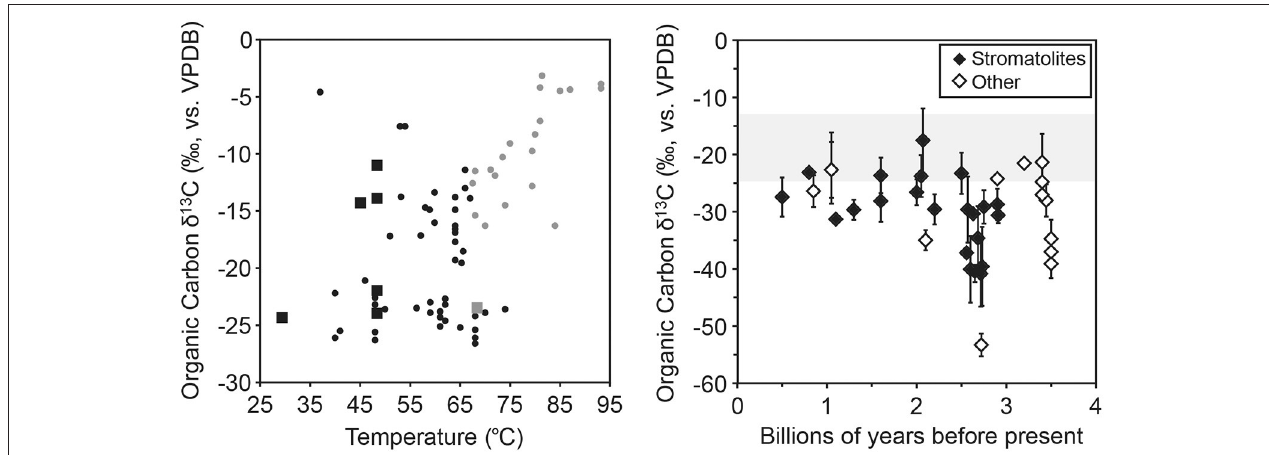
FIGURE 4 | Literature organic carbon δ 13 C data from hydrothermal systems (left) and the rock record (right). Left: Comparison of results from this study (closed squares) to literature (closed circles) organic carbon δ 13 C values for hydrothermal biomass, plotted against temperature. Phototrophic communities are in black, chemotrophic in gray. Literature values from Estep (1984), van der Meer et al. (2000), Havig et al. (2011), Jennings et al. (2017). Right: Average literature organic carbon δ 13 C values for rock units with stromatolites (filled diamonds) or filaments and mats (open diamonds), with standard deviations for units with more than one analysis. The gray shaded area indicates the range of values of organic carbon δ 13 C values from this study. Literature values are provided as part of the Supplementary Online Material and are from Eichmann and Schidlowski (1975); Schidlowski et al. (1975); Barghoorn et al. (1977); Hayes et al. (1983); Kaufman et al. (1991); Strauss and Beukes (1996); Melezhik et al. (1997); Watanabe et al. (1997); House et al. (2000); Sreenivas et al. (2001); Ueno et al. (2001); Westall et al. (2001, 2006a,b); Noffke et al. (2003, 2006); Ono et al. (2006); Thomazo et al. (2009); Yoshiya et al. (2012); Williford et al. (2016) .